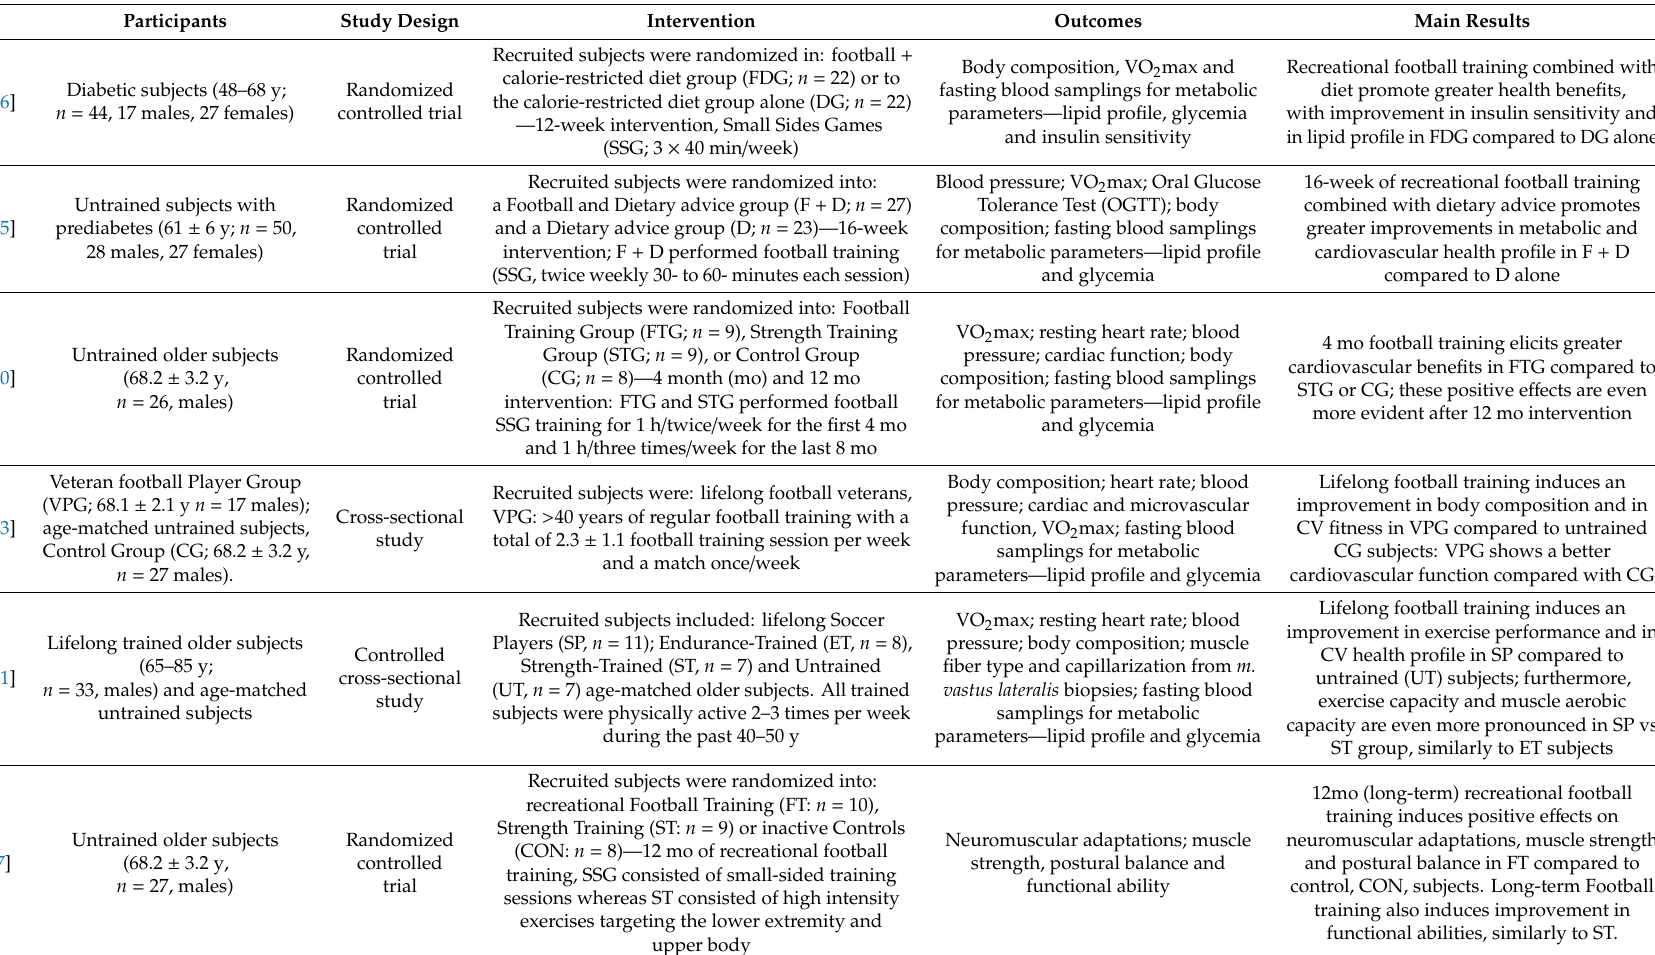
Table 1. Characteristics of selected studies on metabolic, CV and musculo-skeletal fitness in older